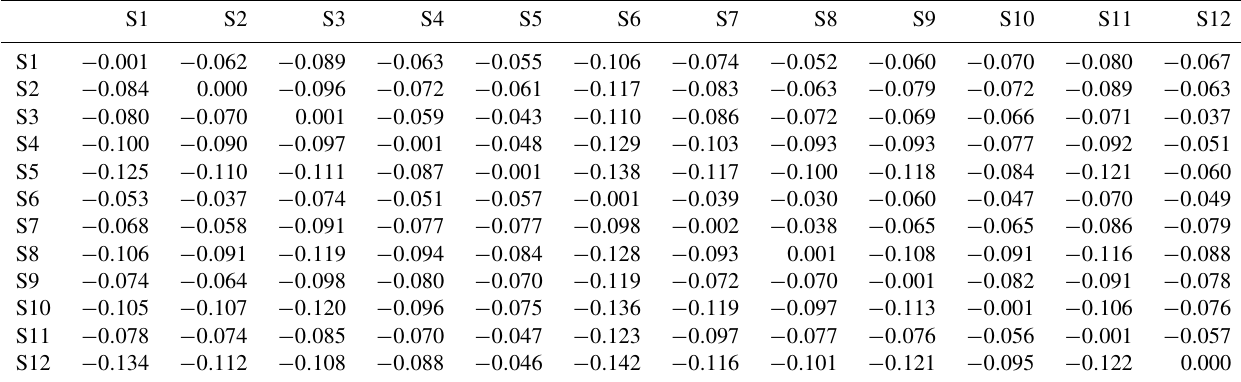
Table 10. Bias of lag-1 cross-correlation of the generated data from the Wilks model. Note that a positive value indicates the overestimation of lag-1 cross-correlation, while a negative value shows